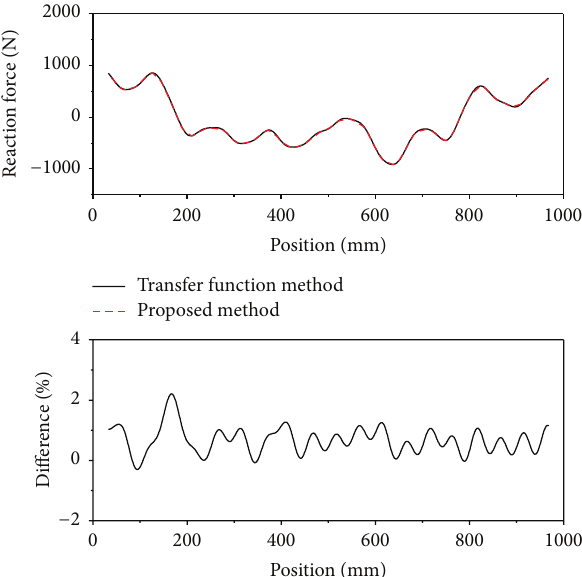
Figure 8: The reaction force calculated using the transfer function method and using the method described